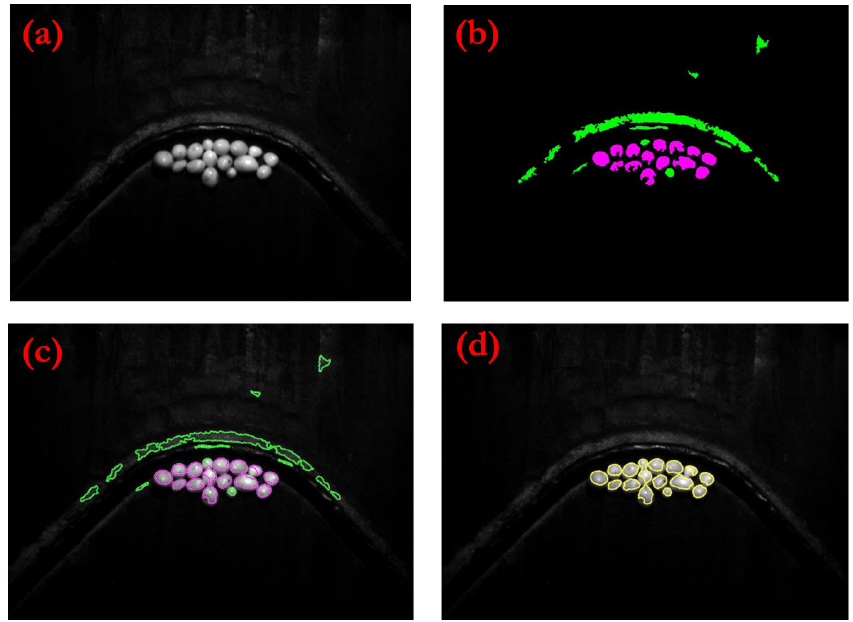
Figure 7. Example of olives segmentation (conveyor belt not completely full). ( a ) Image acquisition. ( b ) Result of the preprocesing step: global thresholding mask in magenta and adaptative thresholding mask in green. ( c ) Level one (magenta) and level two (green) segmentation. ( d ) Final segmentation result.